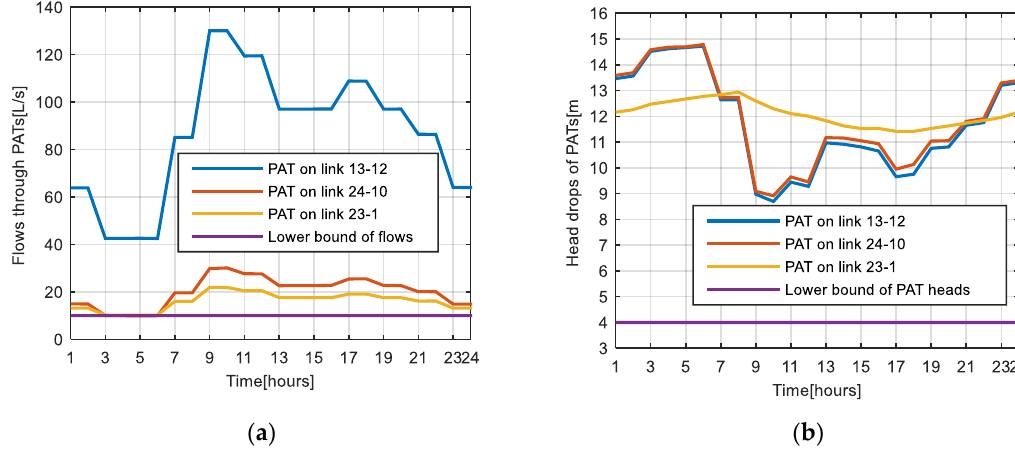
Figure 5. ( a ) Flow profiles through PATs; ( b ) Head drops of PATs for 24 h (scenario 2).